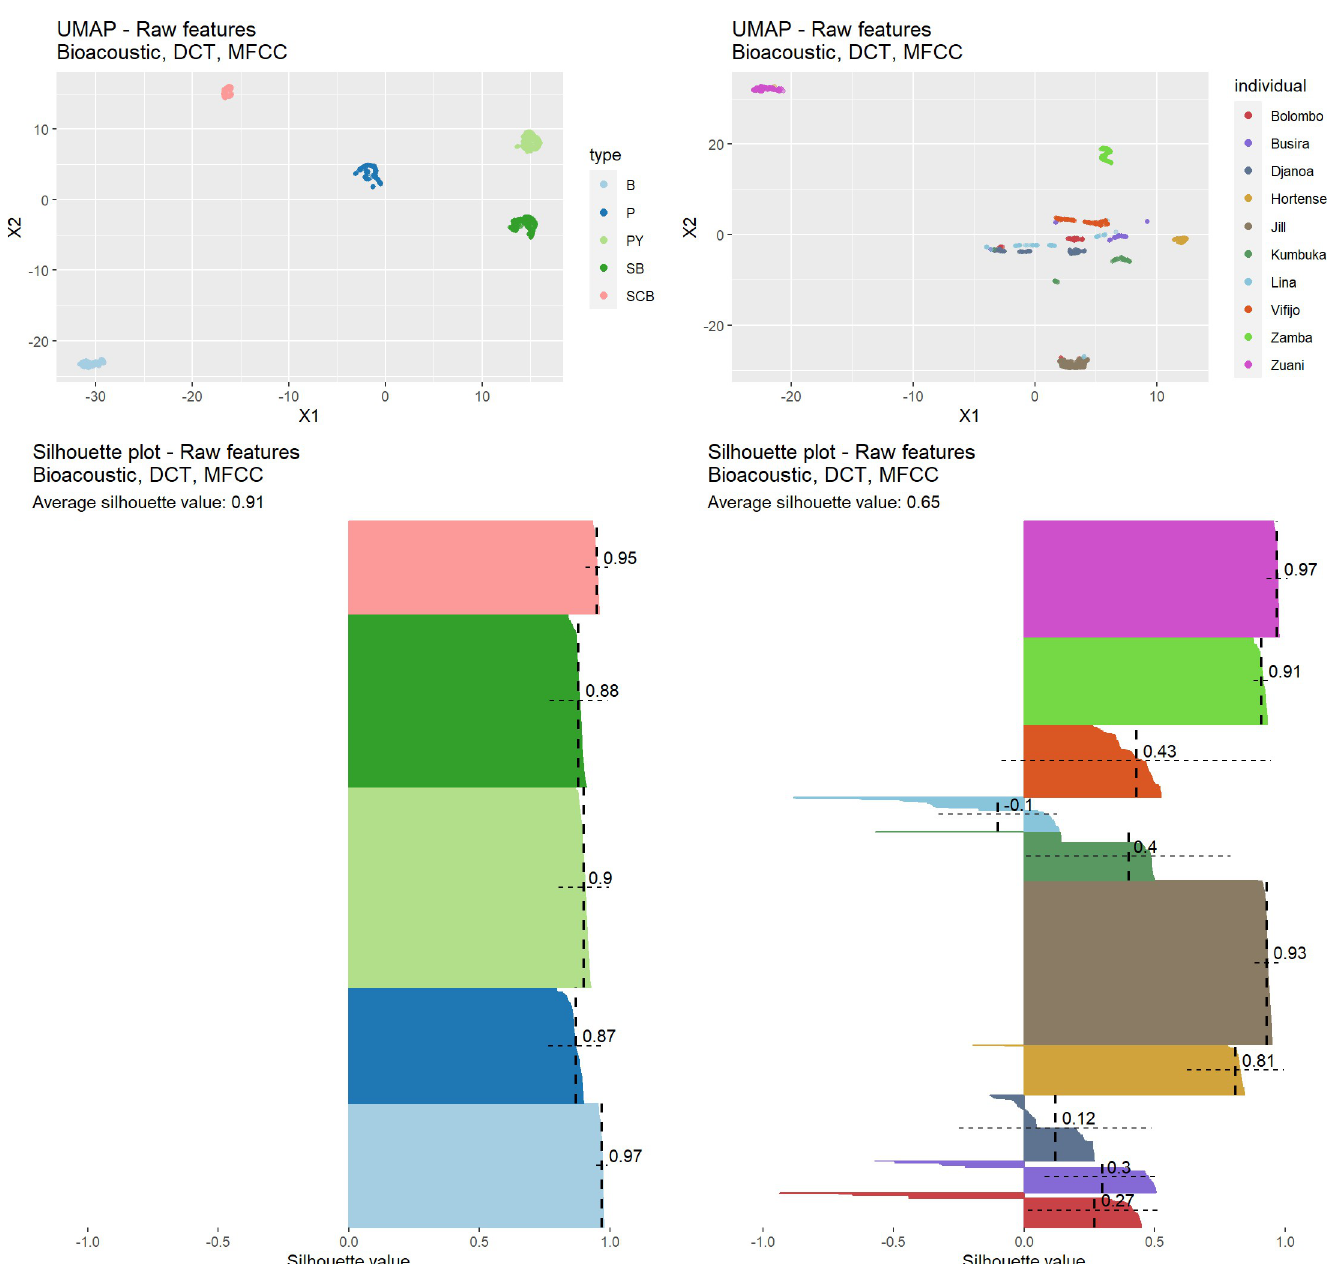
Fig 5. Projections of bonobo calls into bidimensional acoustic spaces through S-UMAP computed on the raw acoustic features of the Bioacoustic, DCT, and MFCC sets (1,560 calls; each dot = 1 call; different colors encode different hand-labeled categories). Left. Top. S-UMAP projection supervised by call types. Bottom. Silhouette profiles corresponding to the call type clustering, built from a 100-repetition distribution of silhouette scores, with averages and standard deviations per call type being represented by dashed vertical and horizontal lines, respectively. Right. Top. S-UMAP projection supervised by individual identities. Bottom. Silhouette profiles corresponding to the individual signature clustering, built from a 100-repetition distribution of silhouette scores, with averages and standard deviations per individual being represented by dashed vertical and horizontal lines,